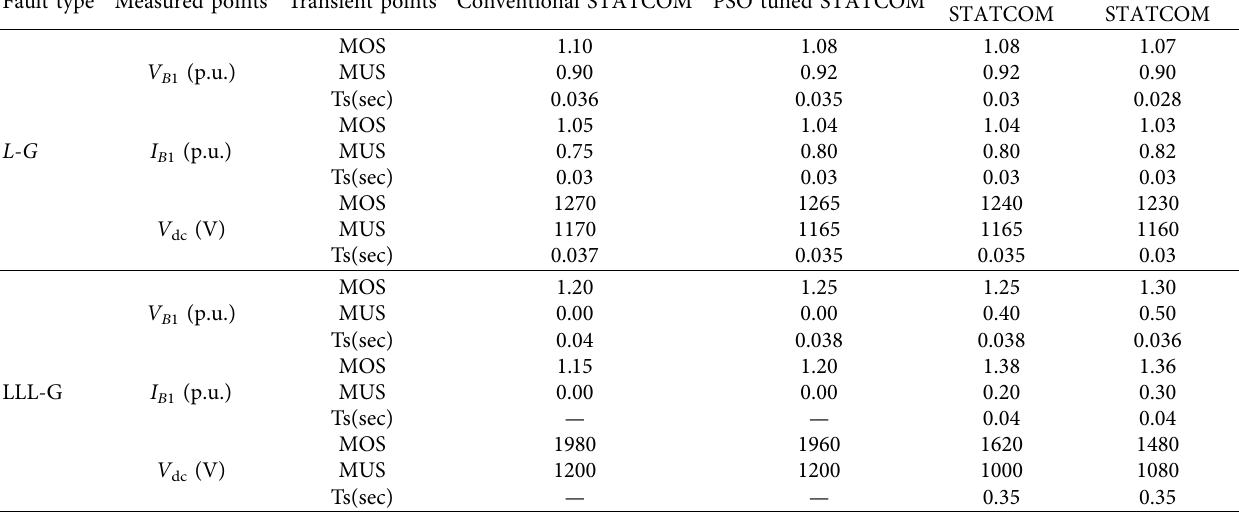
Table 11: Numerical summary of results obtained.